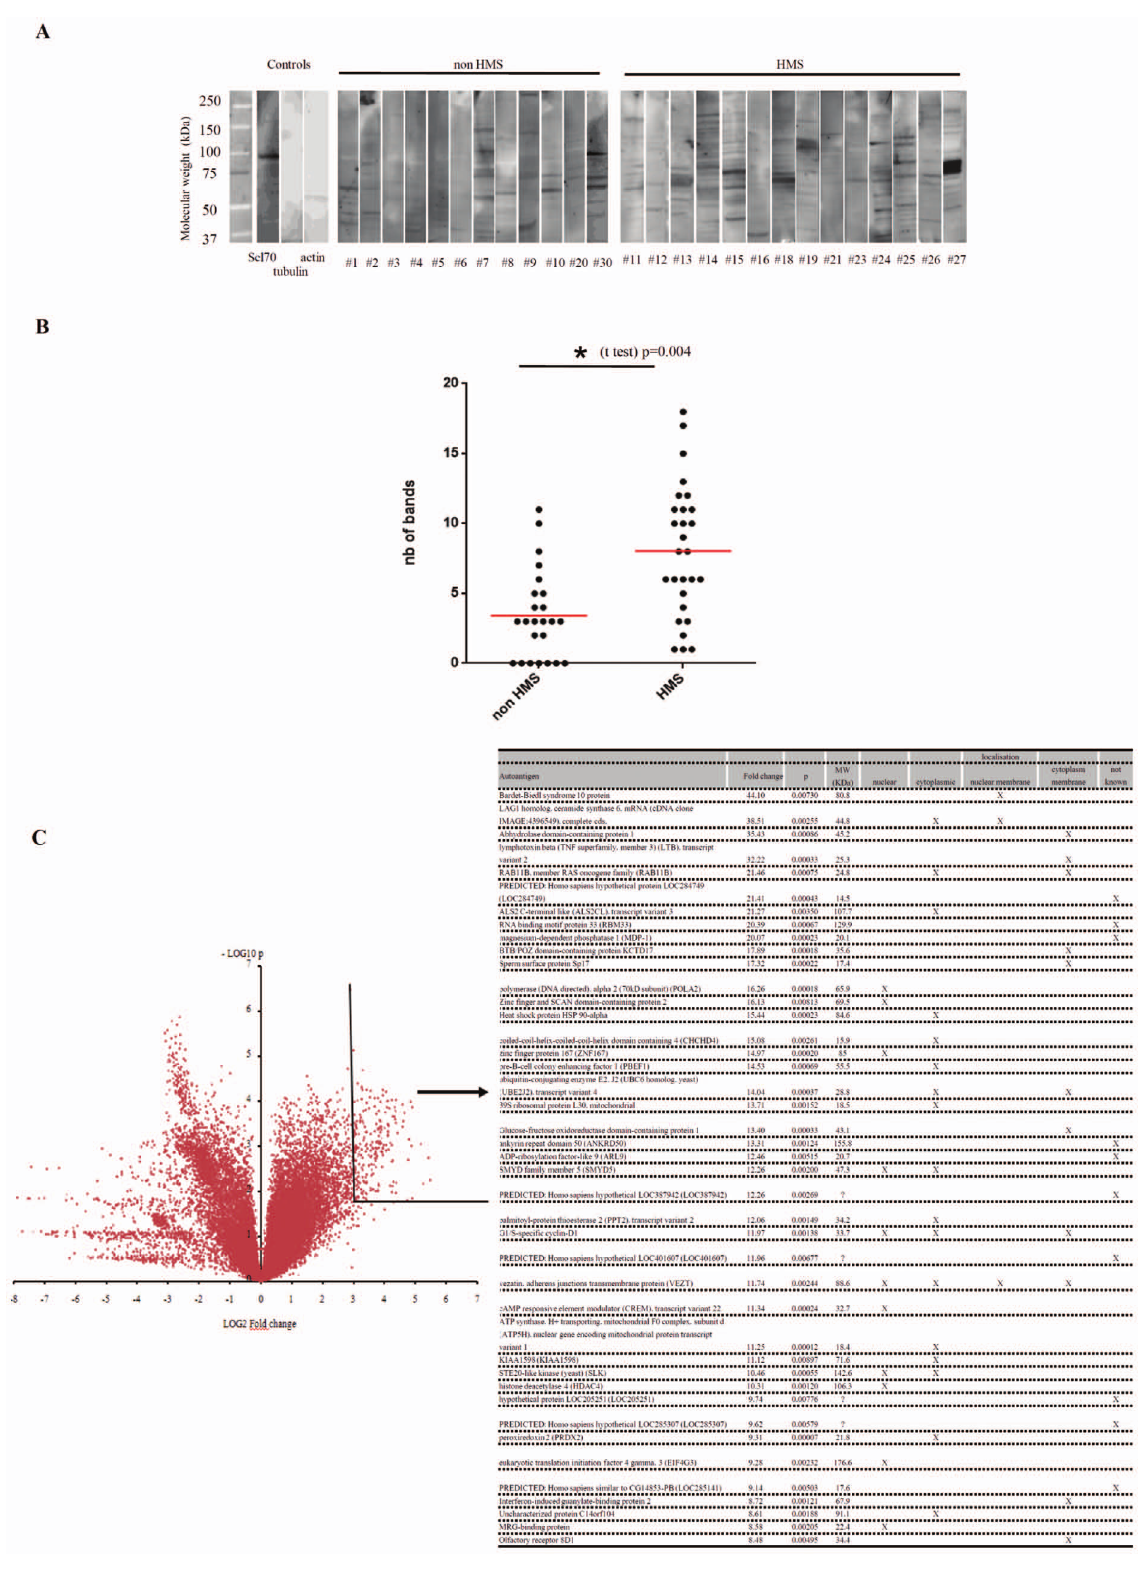
Figure 3. Polyclonal autoantibodies of IgG isotype are responsible for the malaria related pattern. A Detection by Western blotting of autoantibodies in the serum of malaria patients recognizing HEp-2 cells proteins. Each lane corresponds to an individual experiment with the serum obtained from indicated patient. Positive control are shown with anti-actin and anti-tubulin monoclonal antibodies and anti-Scl70 positive serum obtained from a patient with systemic sclerosis. B Comparison of the number of bands observed on Western blotting gels in non-HMS (n=12) and HMS (n=14) malaria. Comparison made using a non-parametric U Mann-Whitney test. C Determination of the targets of malarial autoantibodies.